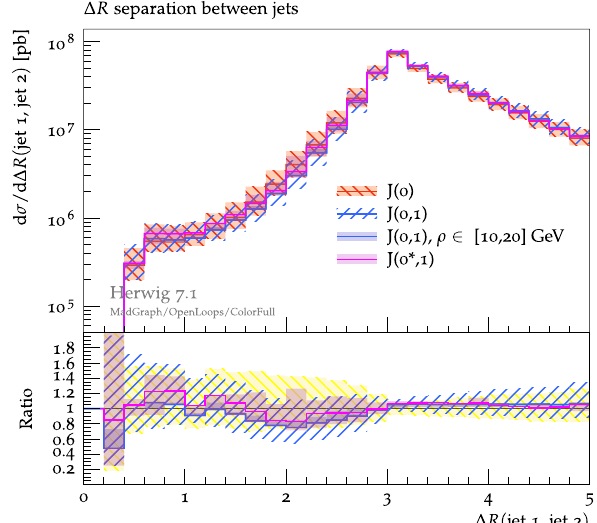
Fig. 27 Δ R separationbetweenthetwohardestjetsindijetproduction. The inclusion of NLO contributions for the production process reduces the scale uncertainties in the region above Δ R = π . The region below π is filled by parton-shower effects